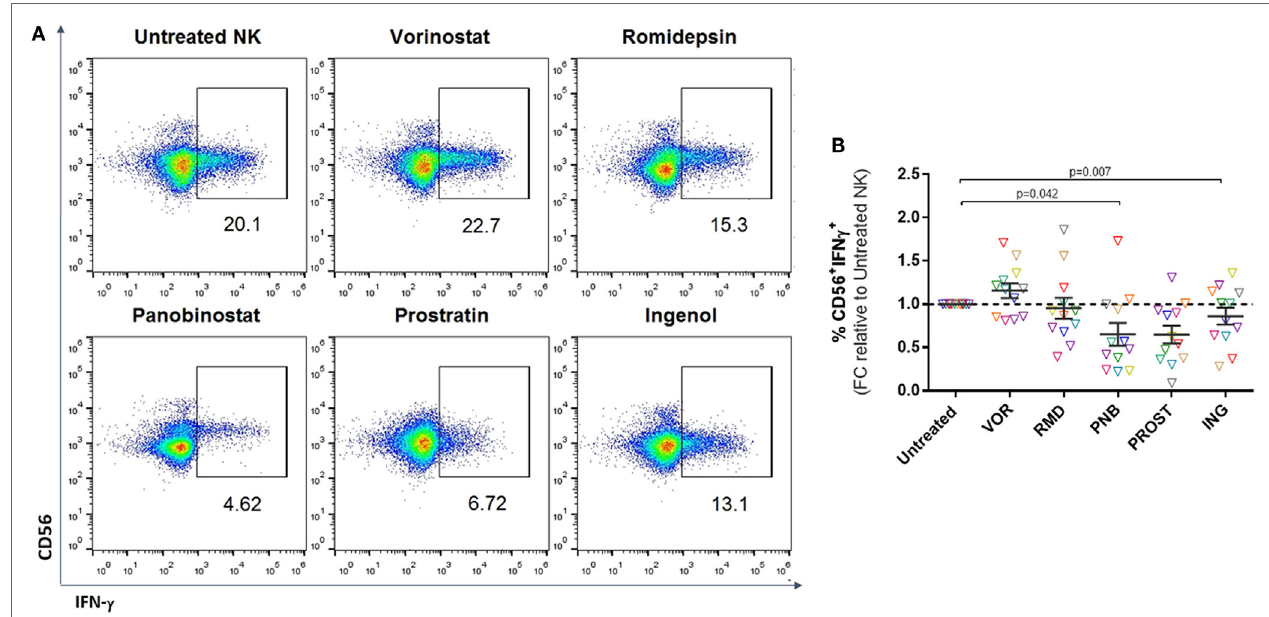
FigUre 4 | cytokine production . Proportion of CD56 + IFN- γ + cells after 4–6 h culture with K562 cells. (a) Representative FACS analysis showing gating strategy after intracellular staining with IFN- γ . (B) Proportion of CD56 + cells positive for IFN- γ expressed as fold change relative to the untreated NK condition. Each color represents cells from a different donor. VOR, RMD, or ING do not have a significant effect on IFN- γ production, while PNB and PROST impaired cytokine production. N =